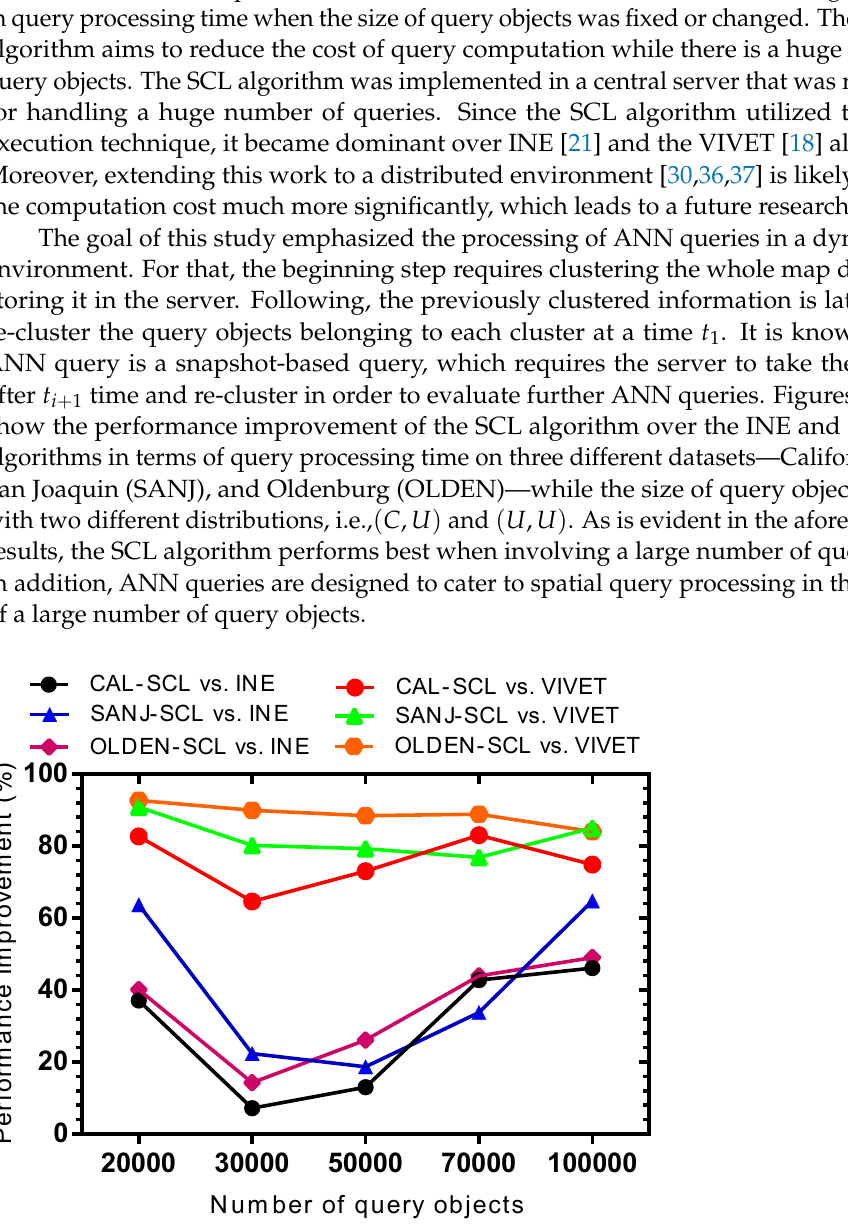
Figure 10. Performance improvement by increasing the query object size following (cid:104) C , U (cid:105)